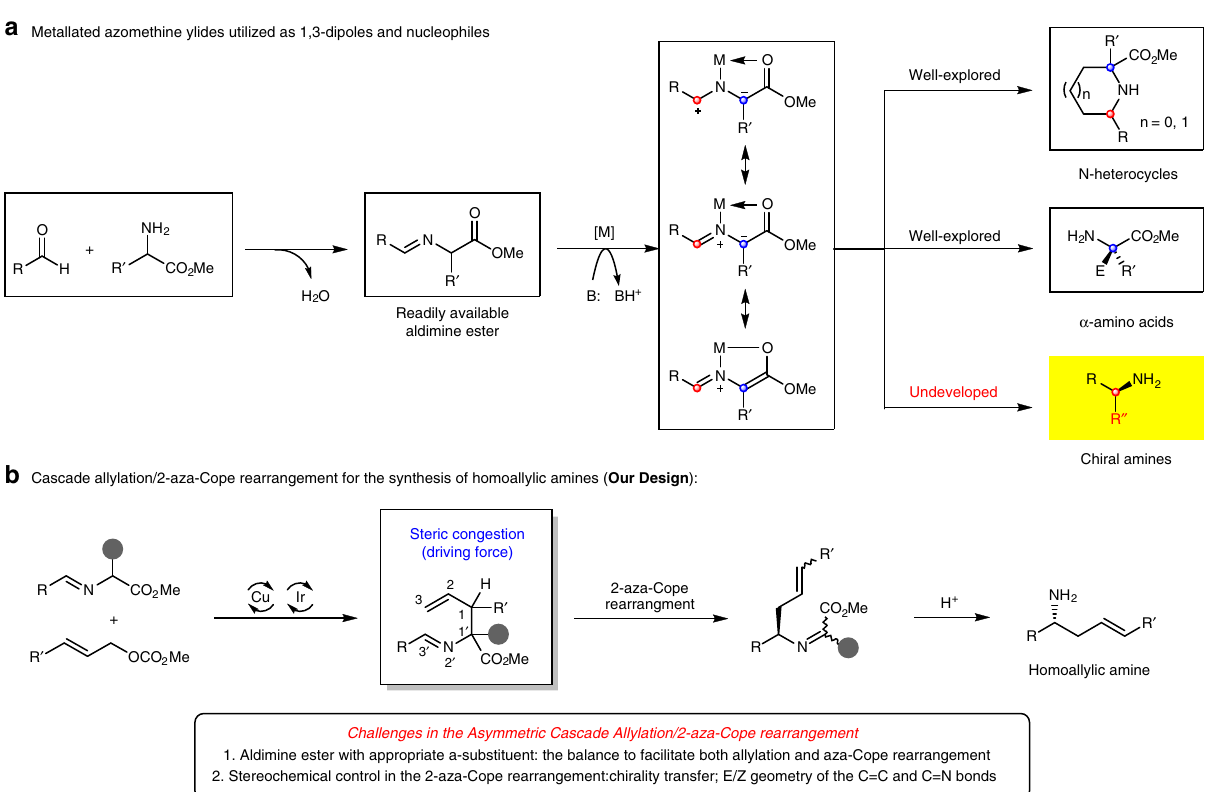
Fig. 1 Metallated azomethine ylide and its synthetic potential in organic synthesis. a Well-established and undeveloped synthetic applications of